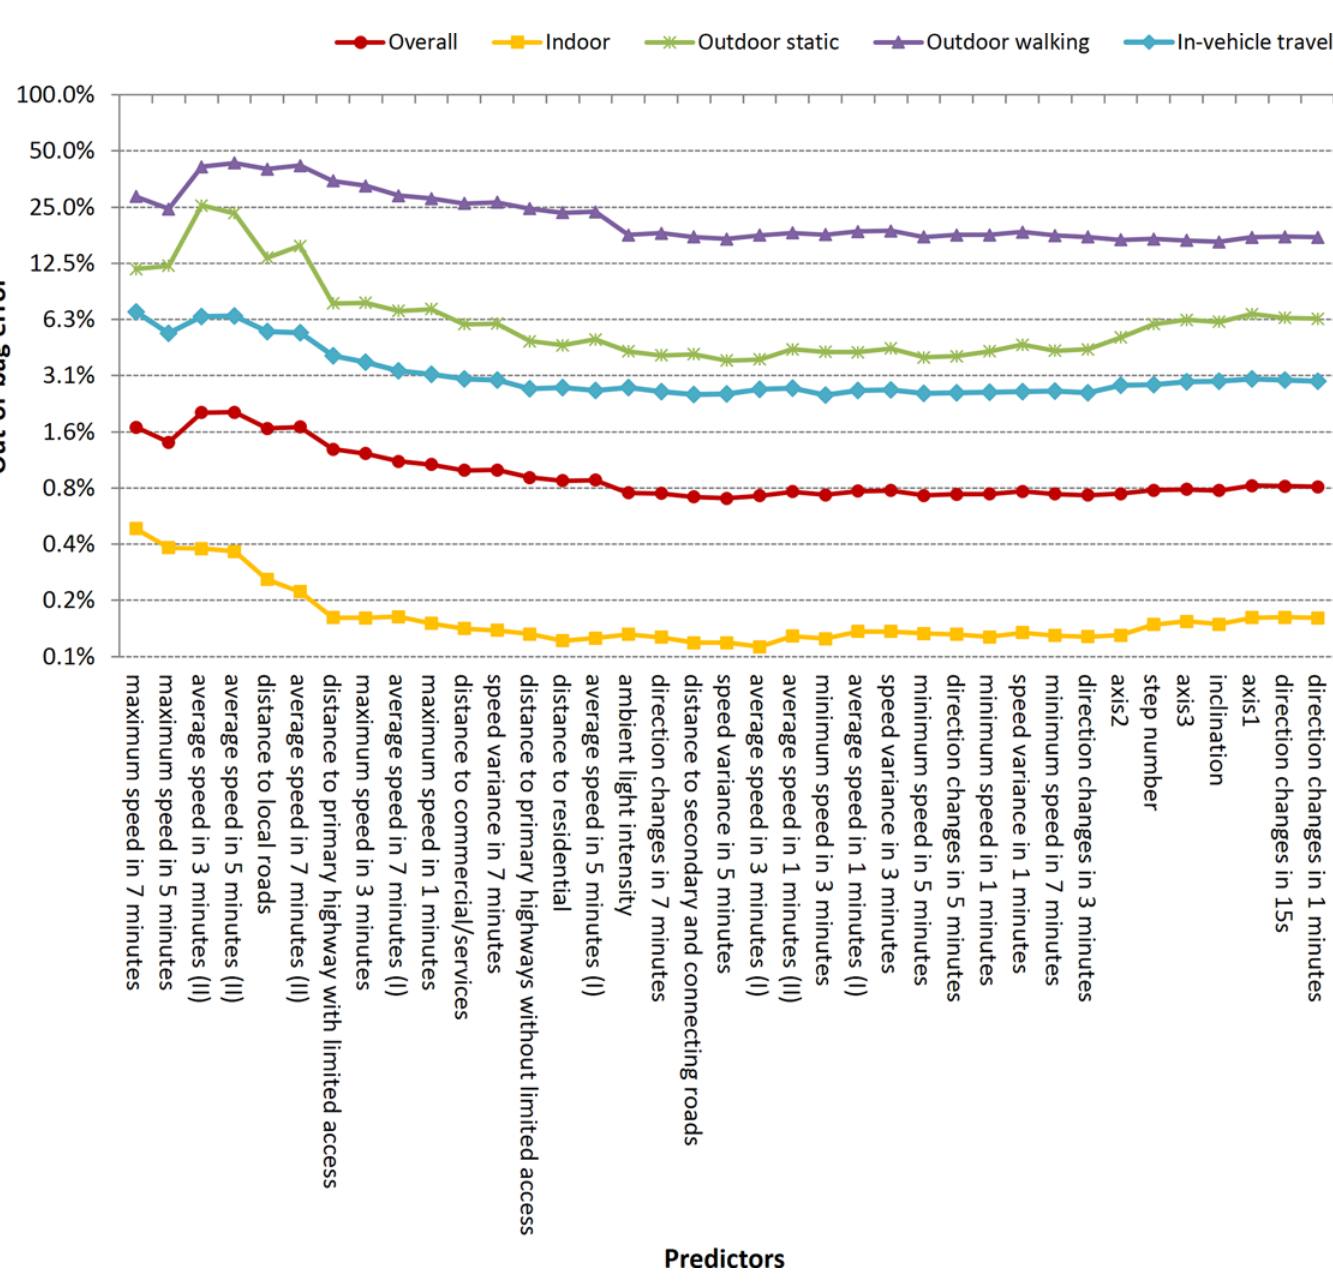
Fig 4. Out-of-bag error variation with different variables (from left to right the variables on the X axis were sequentially entered into the random forests